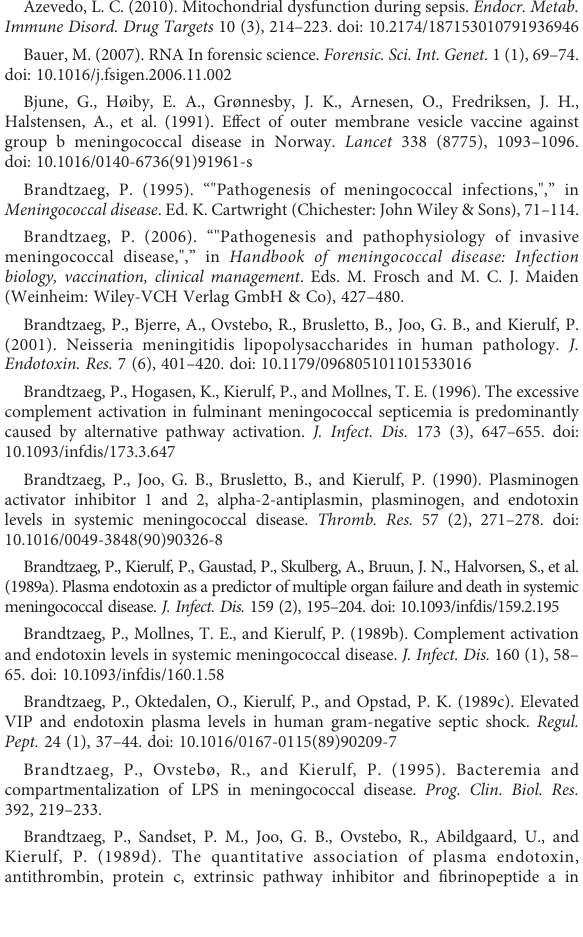
pathway, and orange or lighter shades of orange indicate a positive Z- score and up-regulation of the pathway. Gray color indicates no activity pattern available. Z-score value >| ± 2| are displayed. Z-score limit 2 for lungs, heart, and kidneys. For liver, Z-score 1, and for spleen, no Z-score limit. Pathways that are not involved for that particular organ or disease are fi ltered away. SUPPLEMENTARY FIGURE 2_2 Transcriptional pro fi les of canonical pathways in fresh frozen (FF) tissue samples from porcinis infused exponentially increasing numbers of N. meningitidis (reference strain H44/76). The fi gure displays the top canonical pathways enriched in each organ. A ≪ core analysis ≫ with FC ≥ |2.0| and p -value < 0.05 was performed separately for each organ. Signi fi cantly enriched canonical pathways were identi fi ed with a right- tailed Fisher ’ s exact test p < 0.05, after correction for multiple testing using the Benjamini – Hochberg method. The Z-score=| ± 2| indicates predicted activation state of canonical pathway. Blue color or lighter shades of blue indicate a negative Z-score and down-regulation of the pathway, and orange or lighter shades of orange indicate a positive Z- score and up-regulation of the pathway. Gray color indicates no activity pattern available. Z-score value >| ± 2| are displayed. For all organs showing canonical pathways corrected by p < 0.05, FC2. BH 1.3 corrected false p -value. Z-score limit 2. Pathways that are not involved for that particular organ or disease are fi ltered away. This fi gure shows the top 12 most activated